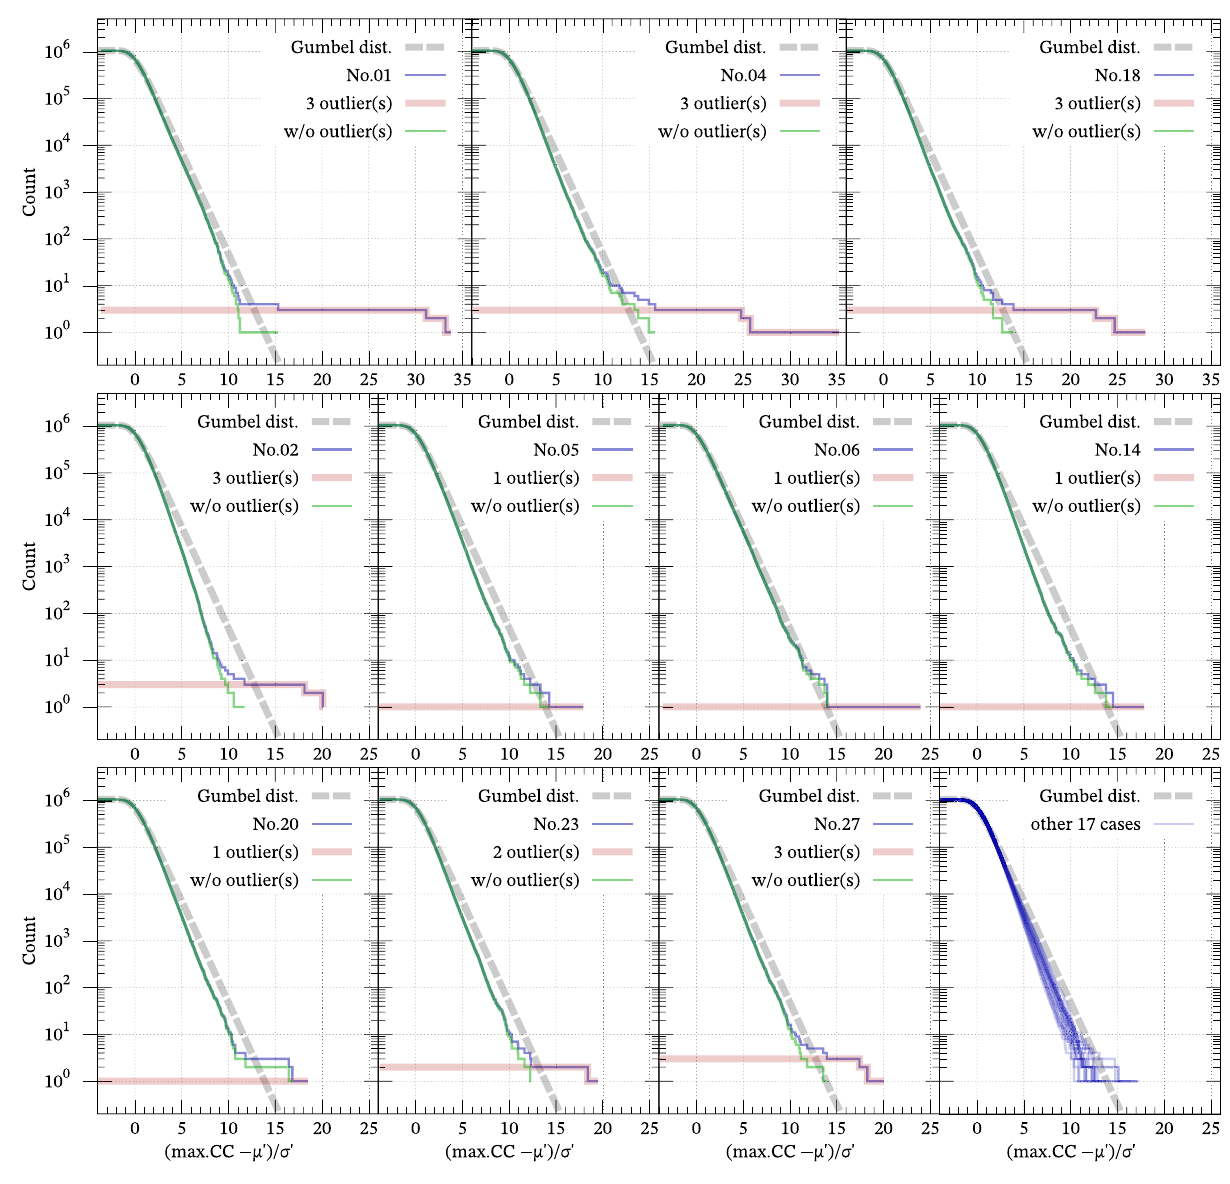
Figure 6. Cumulative distributions of normalized NCC (blue) and the Gumbel distribution with µ ′ = 0 and σ ′ = 1 as the fitting curve (gray) for the 27 templates of Table S.1. Red steps indicate detected outliers in terms of the minimization of AIC. Seventeen cases accompanied by no outliers are plotted all together in the right